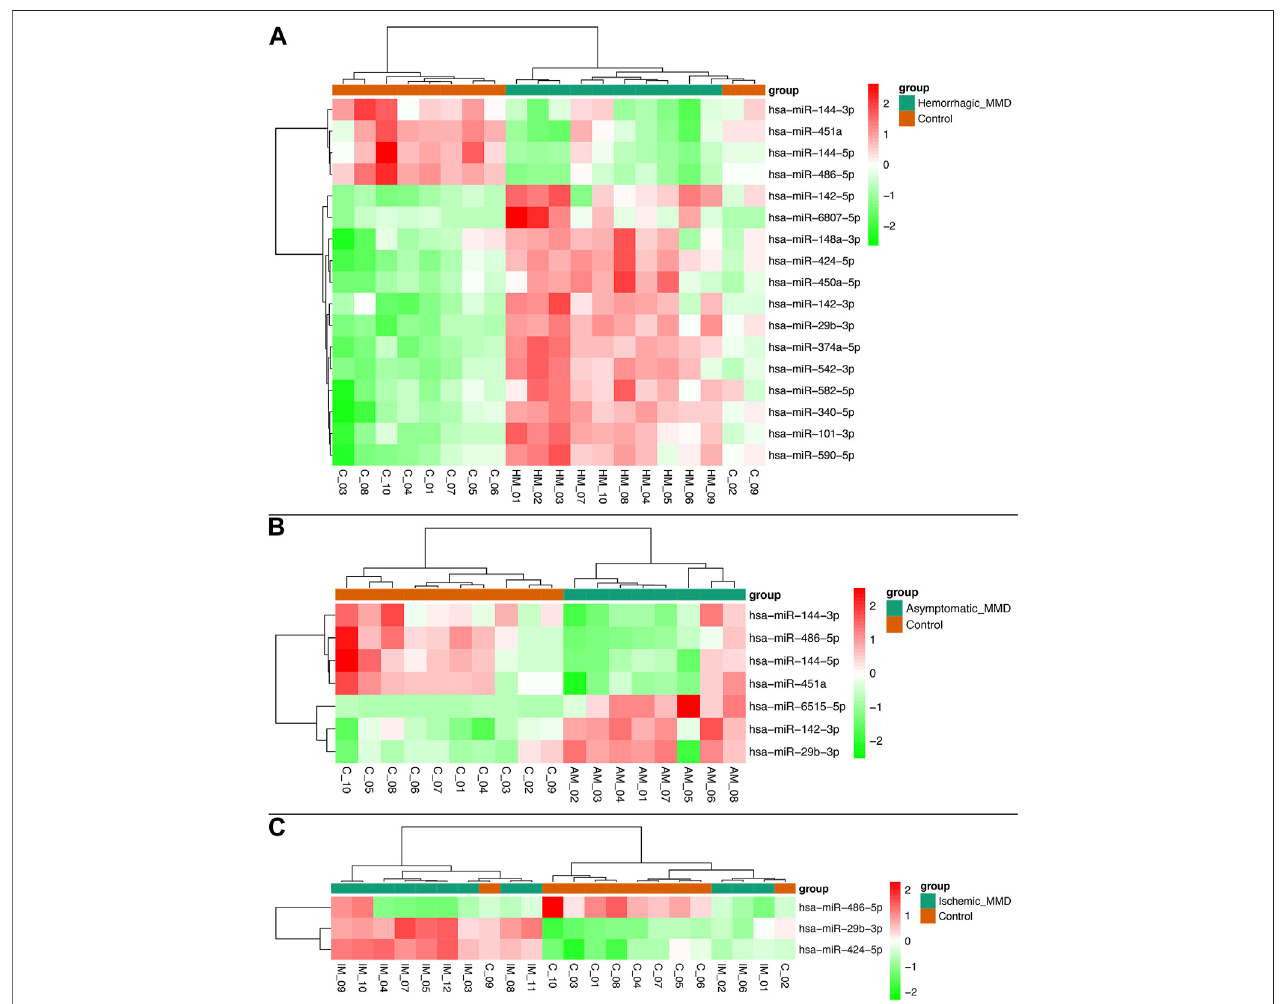
FIGURE 2 | Heat map of differentially expressed miRNAs between subtypes of MMD patients and healthy controls. Seventeen miRNAs were found to be differentially expressed in hemorrhagic MMD patients, with 13 upregulated and 4 downregulated (A) . Seven miRNAs were differentially expressed in asymptomatic MMD patients, with 3 upregulated and 4 downregulated (B) . Three miRNAs were differentially expressed in ischemic MMD patients, with 2 upregulated and 1 downregulated (C) .